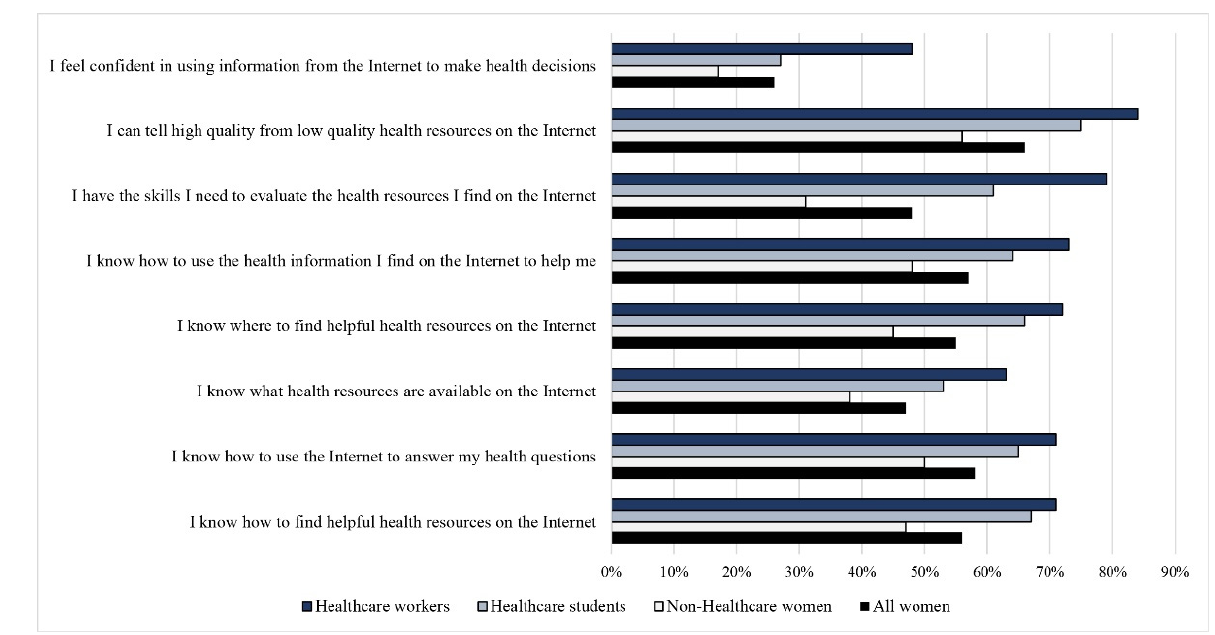
Figure 3. IT-eHealth Literacy Scale agreement in healthcare workers, students, non-healthcare women, and all women.